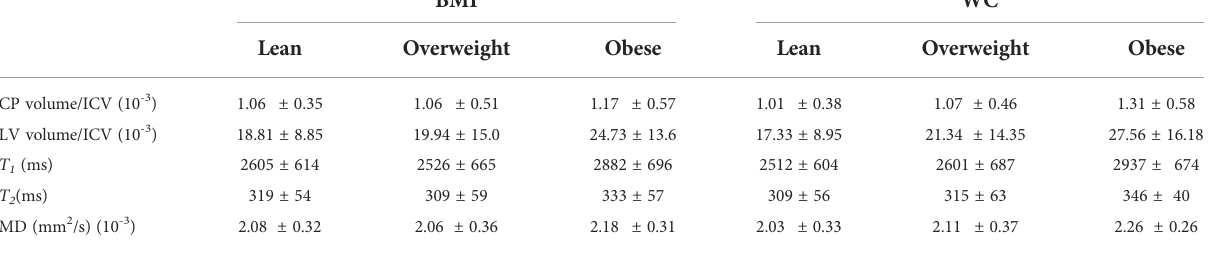
TABLE 6 Mean and standard deviation (SD) values of each magnetic resonance imaging (MRI) metric. Each group was strati fi ed using the established body mass index (BMI) cutoff points for lean participants (BMI < 25), overweight participants (25 ≤ BMI < 30), and participants with obesity (BMI ≥ 30) or using the established waist circumference (WC) cutoff points for lean participants (WC < 94 cm for men and WC < 80 cm for women), overweight participants (94 ≤ WC < 102 for men and 80 ≤ WC < 88 for women), and participants with obesity (WC ≥ 102 for men and WC ≥ 88 for women).